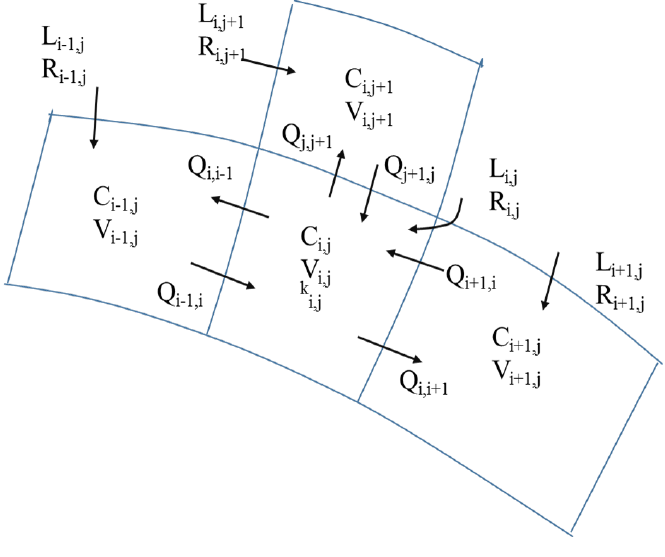
Figure 5. A diagram of tidal model segments.